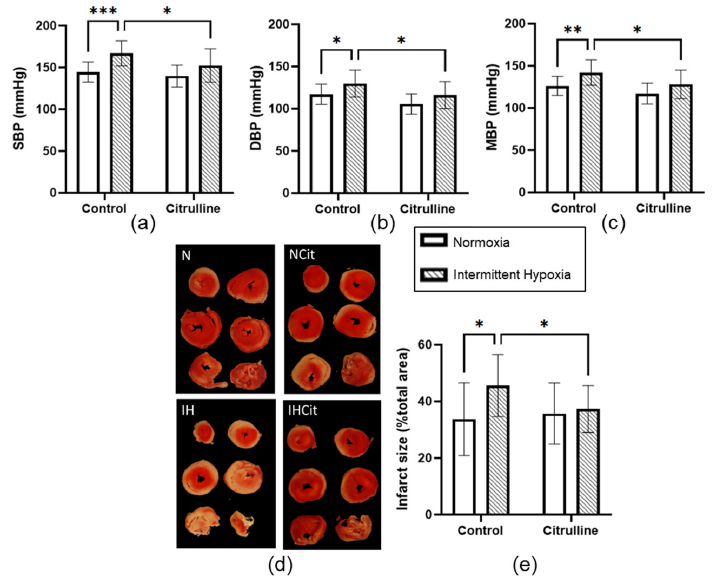
Figure 3. Citrulline supplementation prevented intermittent hypoxia (IH)-induced increase in blood pressure (BP) and infarct size. ( a ) Systolic blood pressure (SBP), ( b ) diastolic blood pressure (DBP), ( c ) mean blood pressure (MBP) expressed in mmHg ( n = 10–13), ( d ) representative images of triphenyl tetrazolium chloride coloration after the ischemia/reperfusion protocol (red zone: viable area; white zone: infarcted area), ( e ) infarct size expressed relative to total heart area ( n = 10–14) from rats exposed to normoxia (N) or IH supplemented with 1 g·kg − 1 ·d − 1 citrulline (Citrulline) or not (Control). Values are represented as mean ± SD. Two-way ANOVA followed by Fisher’s LSD test. * p < 0.05, ** p < 0.01, *** p < 0.001.